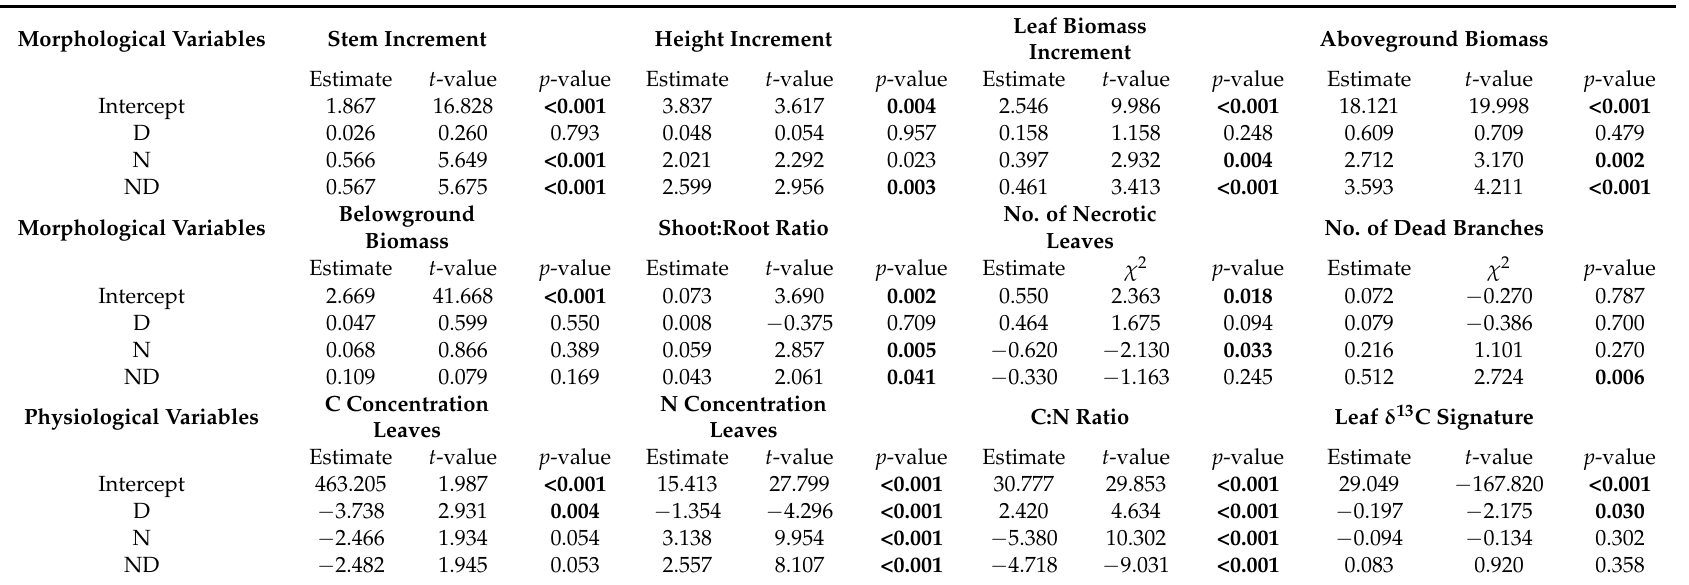
Table 1. Results of mixed-effects models (LMM and GLMM) for treatment effects in response to morphological and physiological variables. Abbreviations of treatments: D = drought treatment, N = nitrogen treatment, ND = combined nitrogen and drought treatment; significant effects ( p < 0.05) are indicated in